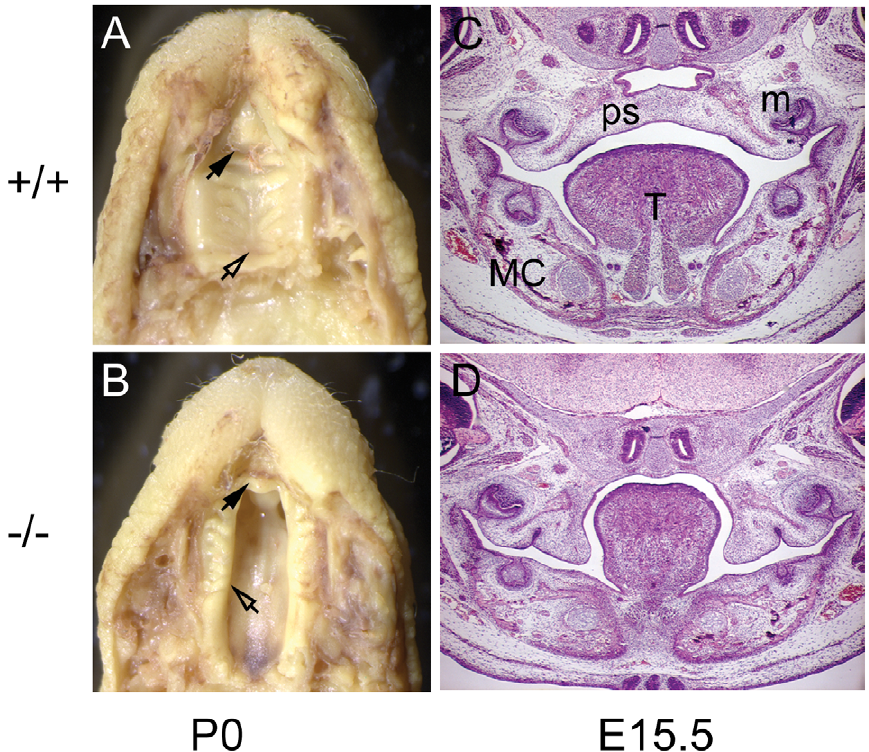
Figure 1. The recessive ENU-induced csp1 mutation in Prdm16 exhibits cleft secondary palate. Homozygous csp1 mutants are born with cleft palate (CP) and die within 24 hours after birth ( A–D ). Bouin’s fixed wild type ( A ) and csp1 (B) mutant newborn pups with CP ( A and B ). The unaffected primary palates (black arrowheads) and fused or cleft secondary palate are evident (open arrowheads in A and B , respectively). Hematoxylin and Eosin-stained coronal sections through wild-type ( C ) and csp1 mutant ( D ) embryonic day (E) 15.5 embryos show impaired palate shelf elevation in mutants. Tongue, T; palate shelf, ps; Meckel’s cartilage, mc and molar, m.